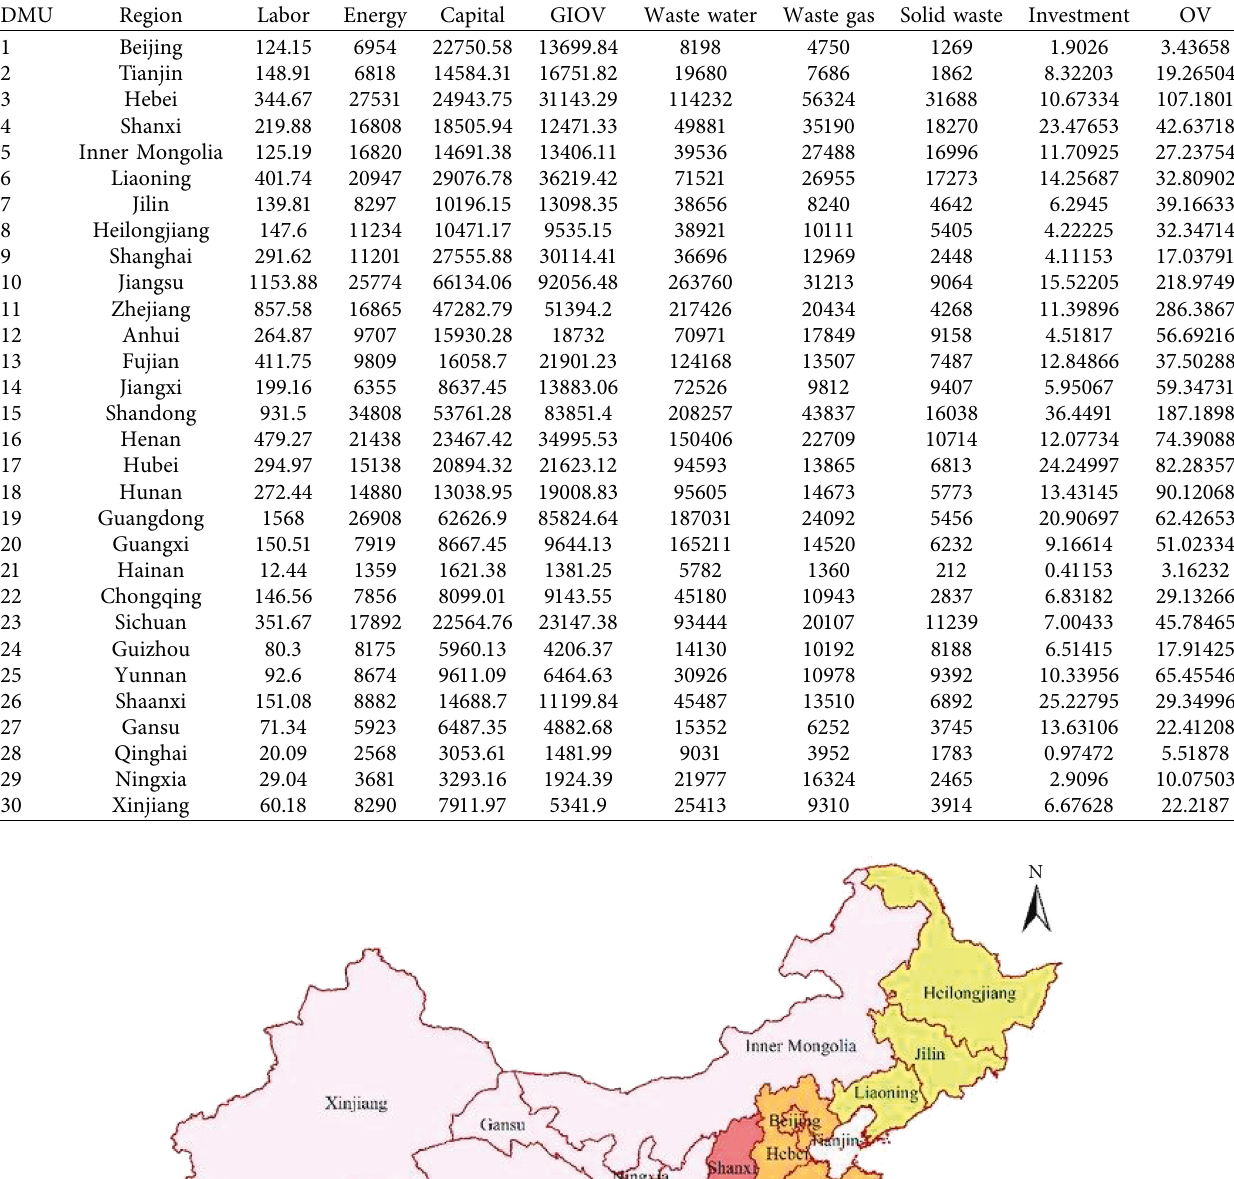
Table 3: Inputs and outputs of industrial production for 30 regions in